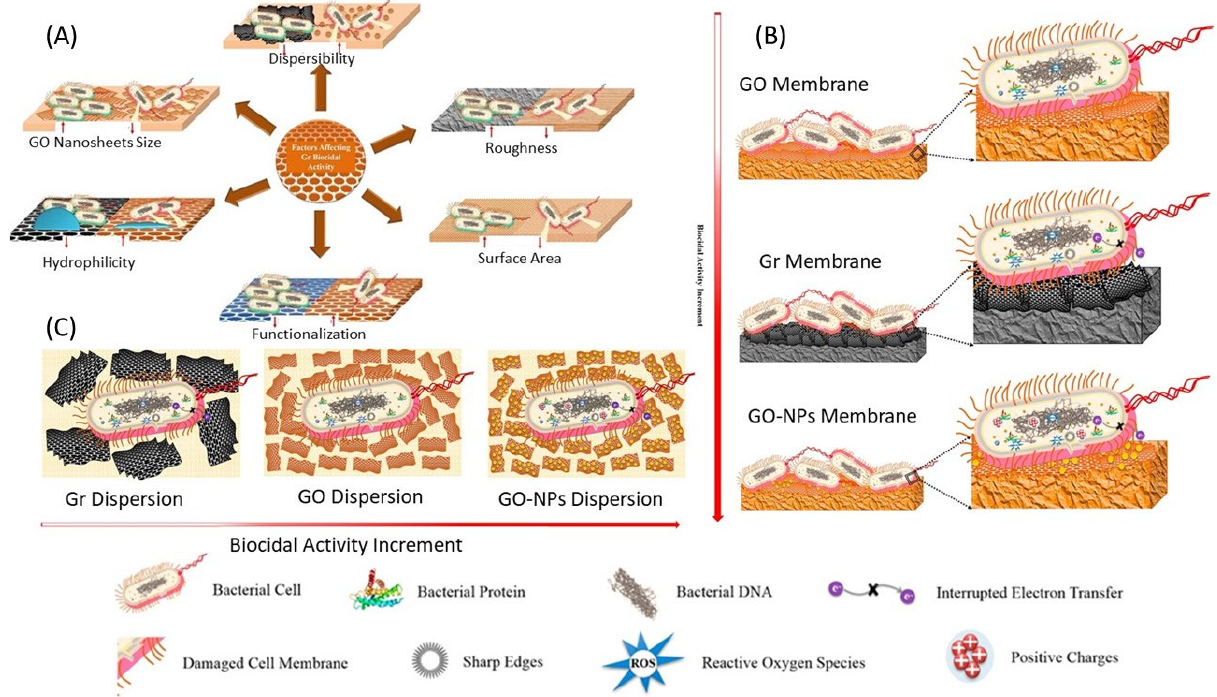
Figure 5. ( A ) The physiochemical properties of graphene nanomaterial relevant to its contradictory antibacterial effect. ( B )Schematic diagram illustrating the antibacterial strength of different G-based suspensions. ( C ) Schematic diagram illustrating the antibacterial strength of different G-based surfaces. Reprinted with permission from ref.